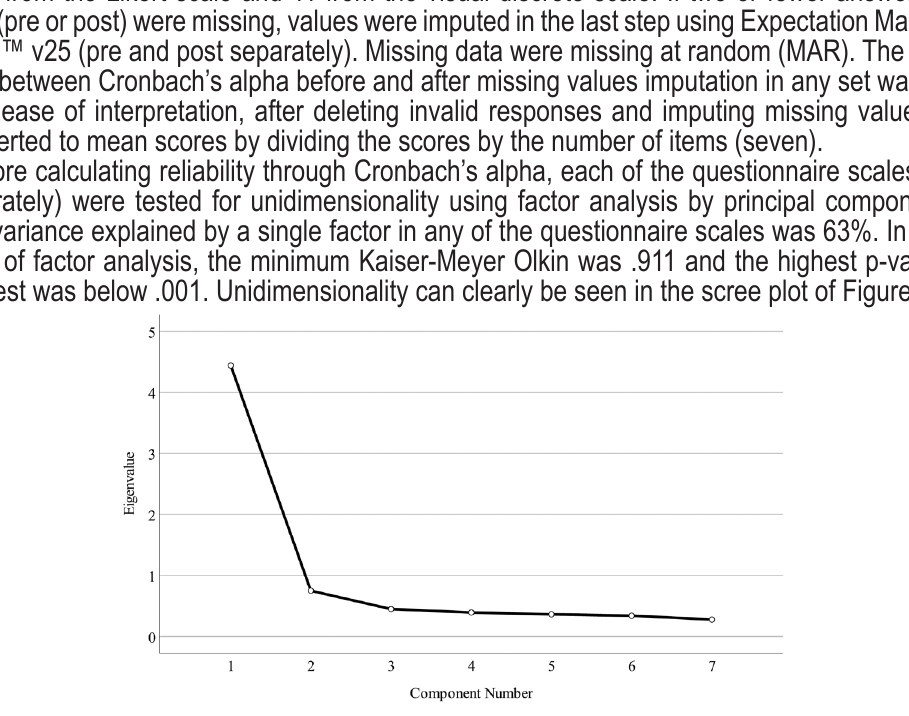
Figure 2. Scree plot of the questionnaire scale using the visual discrete scale (pre). The number of components with eigenvalue over 1 is the number of dimensions (underlying constructs) in the